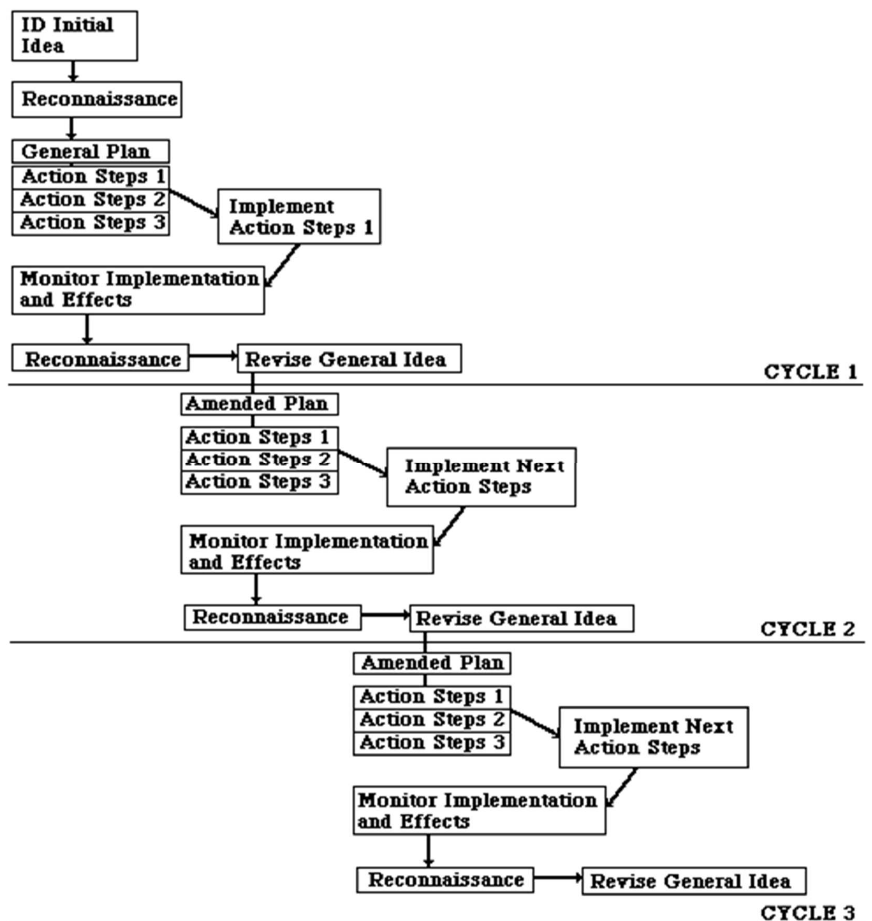
Figure 1. Elliot’s research